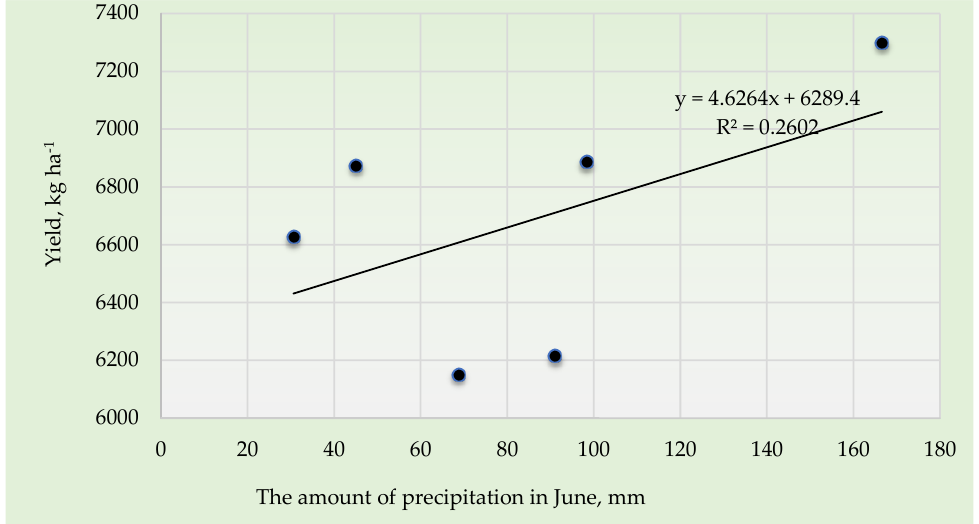
Figure 2. Relationship between June rainfall and maize yield, 2016 – 2021. Table 4. Influence of experimental factors on the number of harvestable plants m -2 , 2016 – 2021. 333